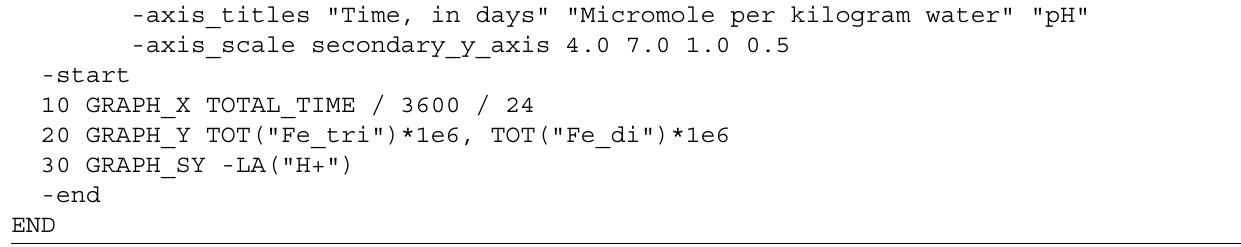
Table 28. Partial input file for example